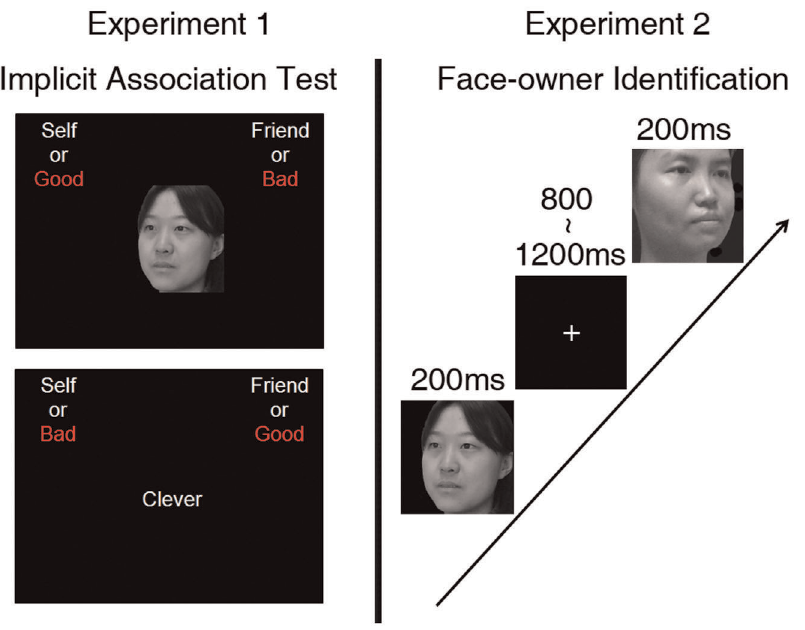
Figure 1. Illustration of the stimuli and procedure in the current study. (a) Illustration of the stimuli and procedure in the IAT in Experiment 1. (b) Illustration of the stimuli and procedure in the face-owner identification task in Experiment 2.